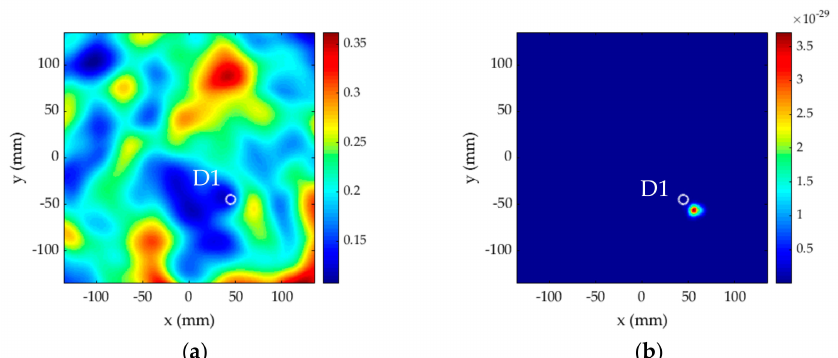
Figure 10. Aggregate damage image for single damage scenario in pitch–catch configuration based on ( a ) compromised fusion scheme; ( b ) conjunctive fusion scheme.